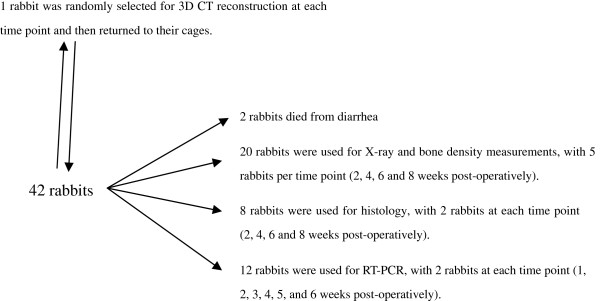
Experimental animals. A total of 42 rabbits were used in this study.